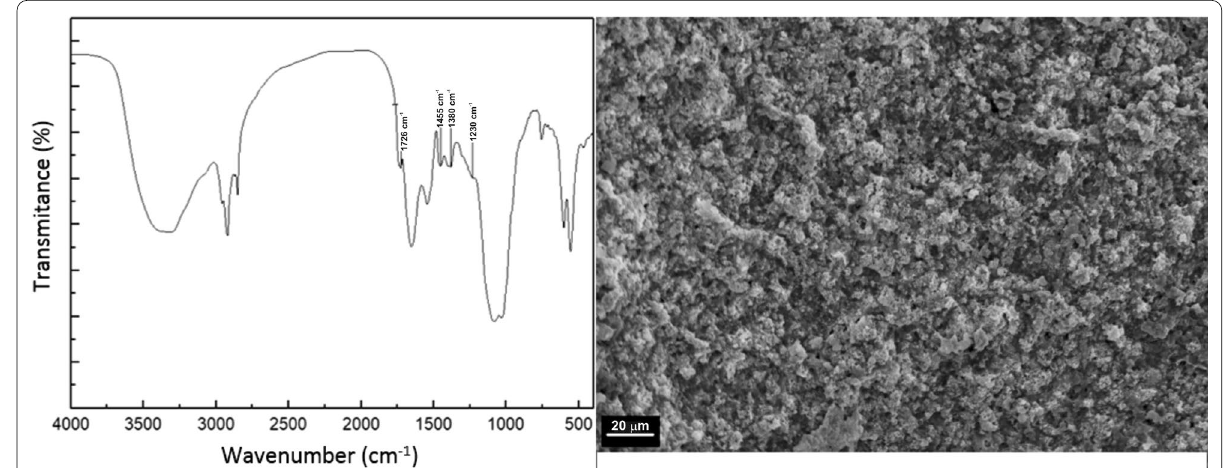
Fig. 4 SEM micrograph and FTIR spectrum of PHA synthesized by B. megaterium using vinasse as carbon